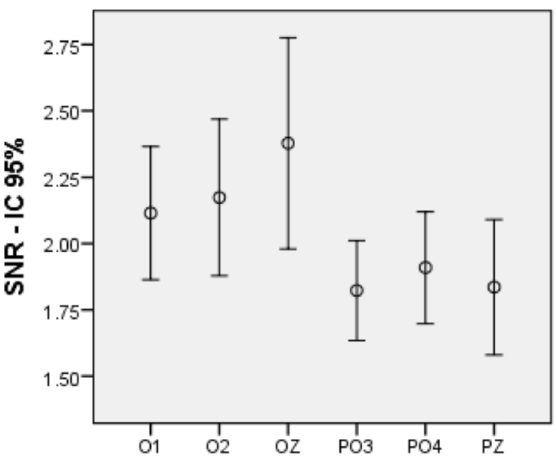
Figure 4. SNR means for the 6 electrodes measured with 95% confidence intervals.